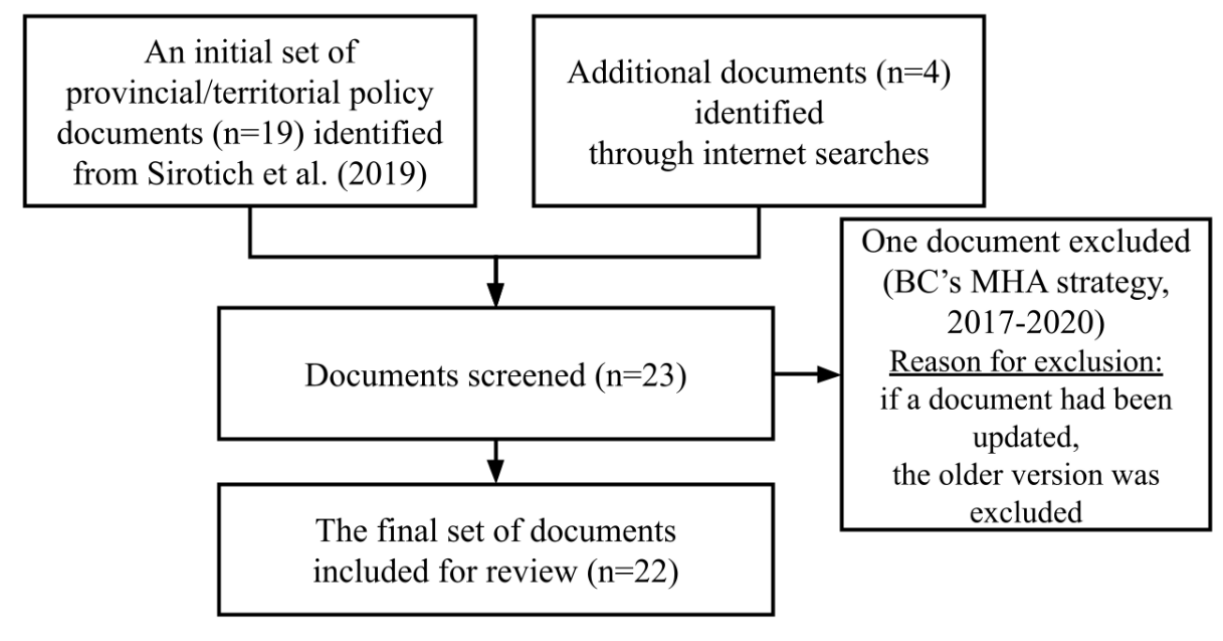
Figure 1. Identification and selection of MHA policy documents. MHA: mental health and